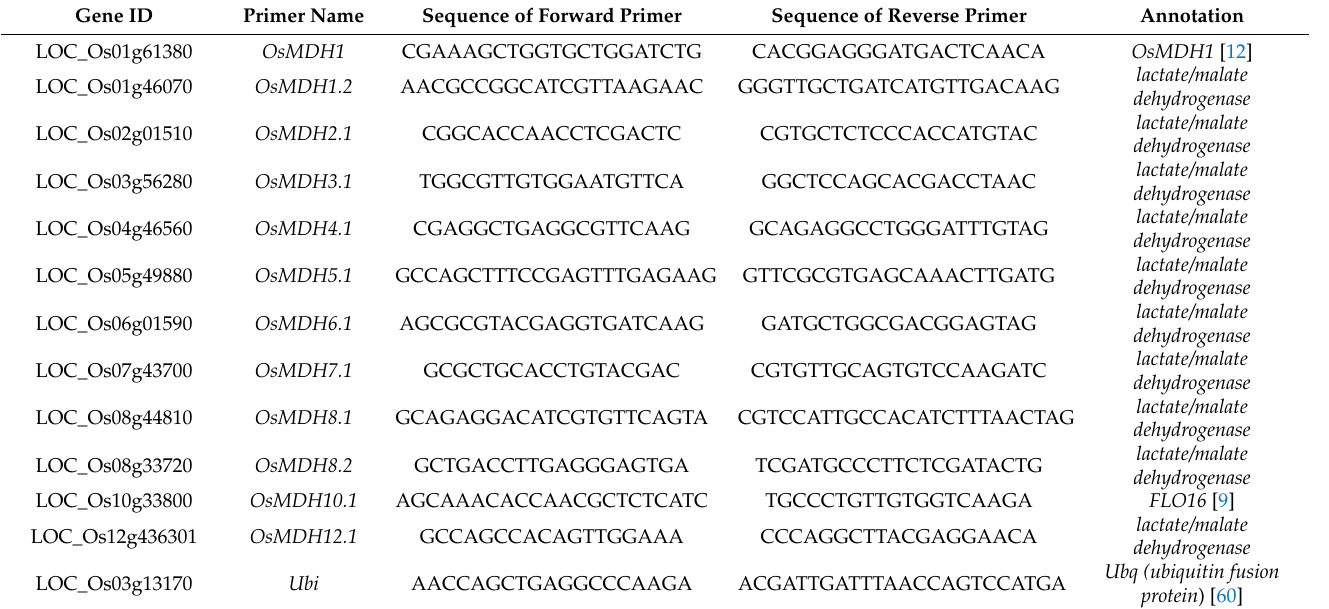
Table 3. Primer sequence for qRT-PCR and gene annotation